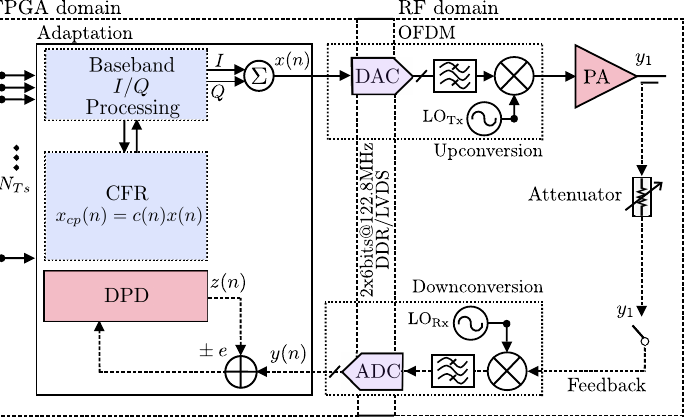
Figure 1. Block diagram for the SDR downlink system process with the feedback observation path